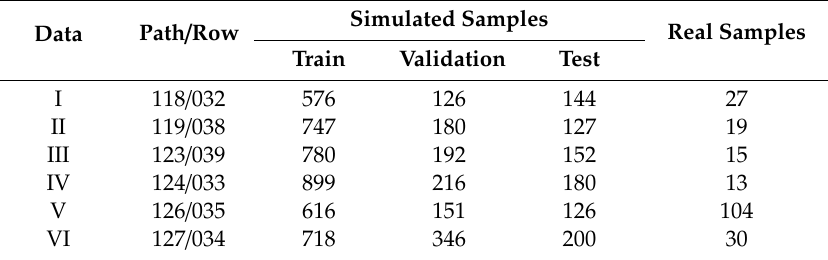
Table 1. Introduction of WHU Cloud